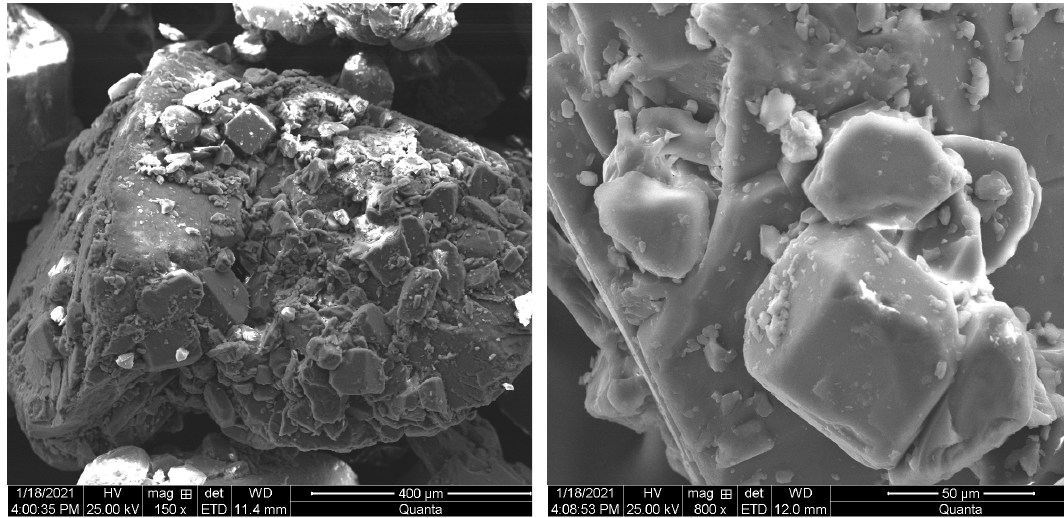
Figure 3. Microscopic morphology of retarder.